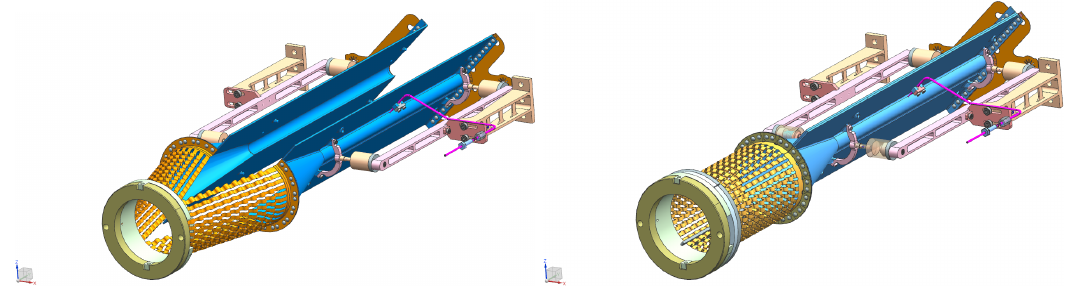
Figure 1: SMOG2 storage cell in open (left) and closed (right) configuration.